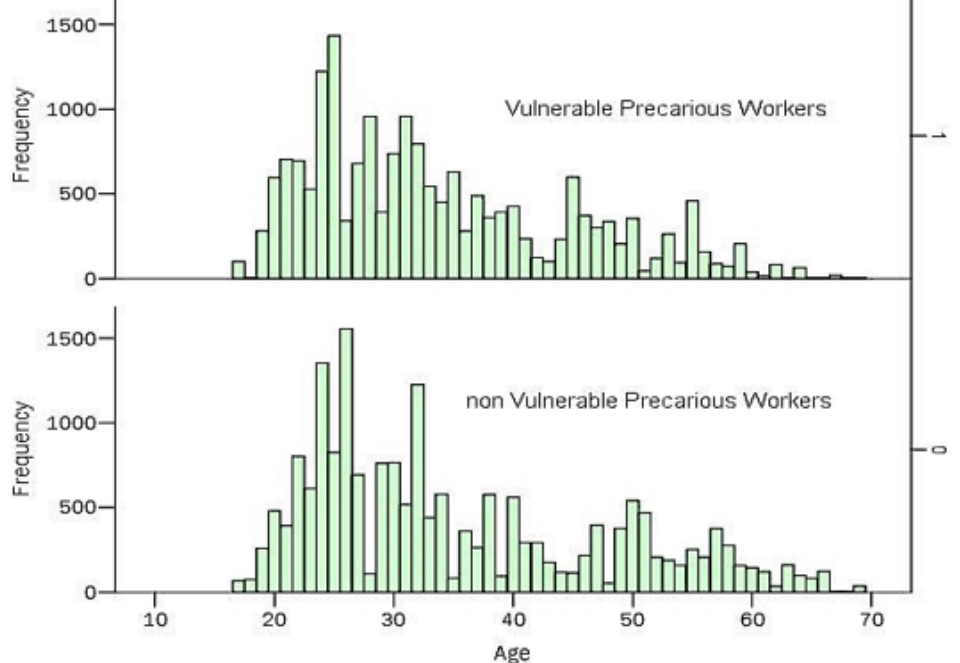
Figure 17. Distribution of precarious workers by age and economic vulnerability Data source: EU- SILC (2020). Eurostat (2020).